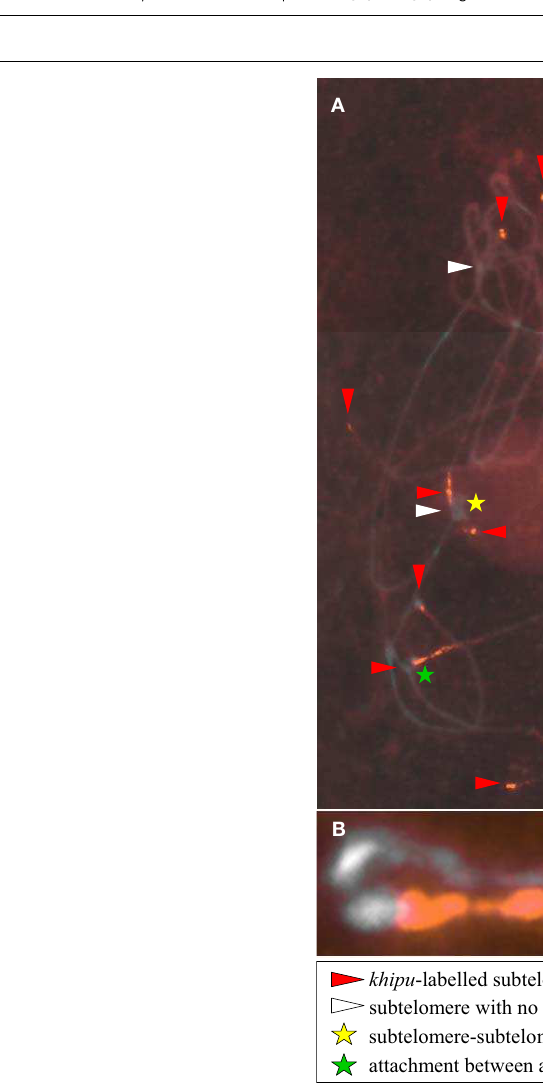
FIGUREA4 | Localization of khipu satellite DNA on JaloEEP558 pachytene chromosomes and evidences of chromosome attachments . Chromosomes are counterstained with DAPI (gray), and khipu signals are in red (original picture). (A) Chromosome termini with